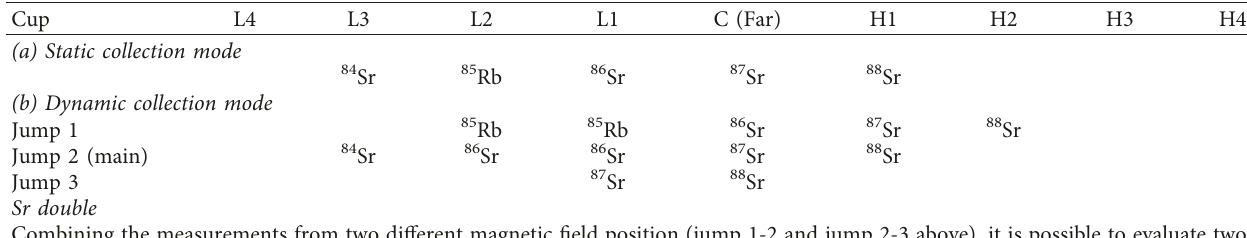
􏽰 ������������������������������������� � [ 87 Sr / 86 Sr ] · [ 87 Sr / 88 Sr ] · [ 88 Sr / 86 Sr ] N 1 - 2 1 2 H1 C C H1 . The numbers outside the parentheses are relative to the three different magnetic field